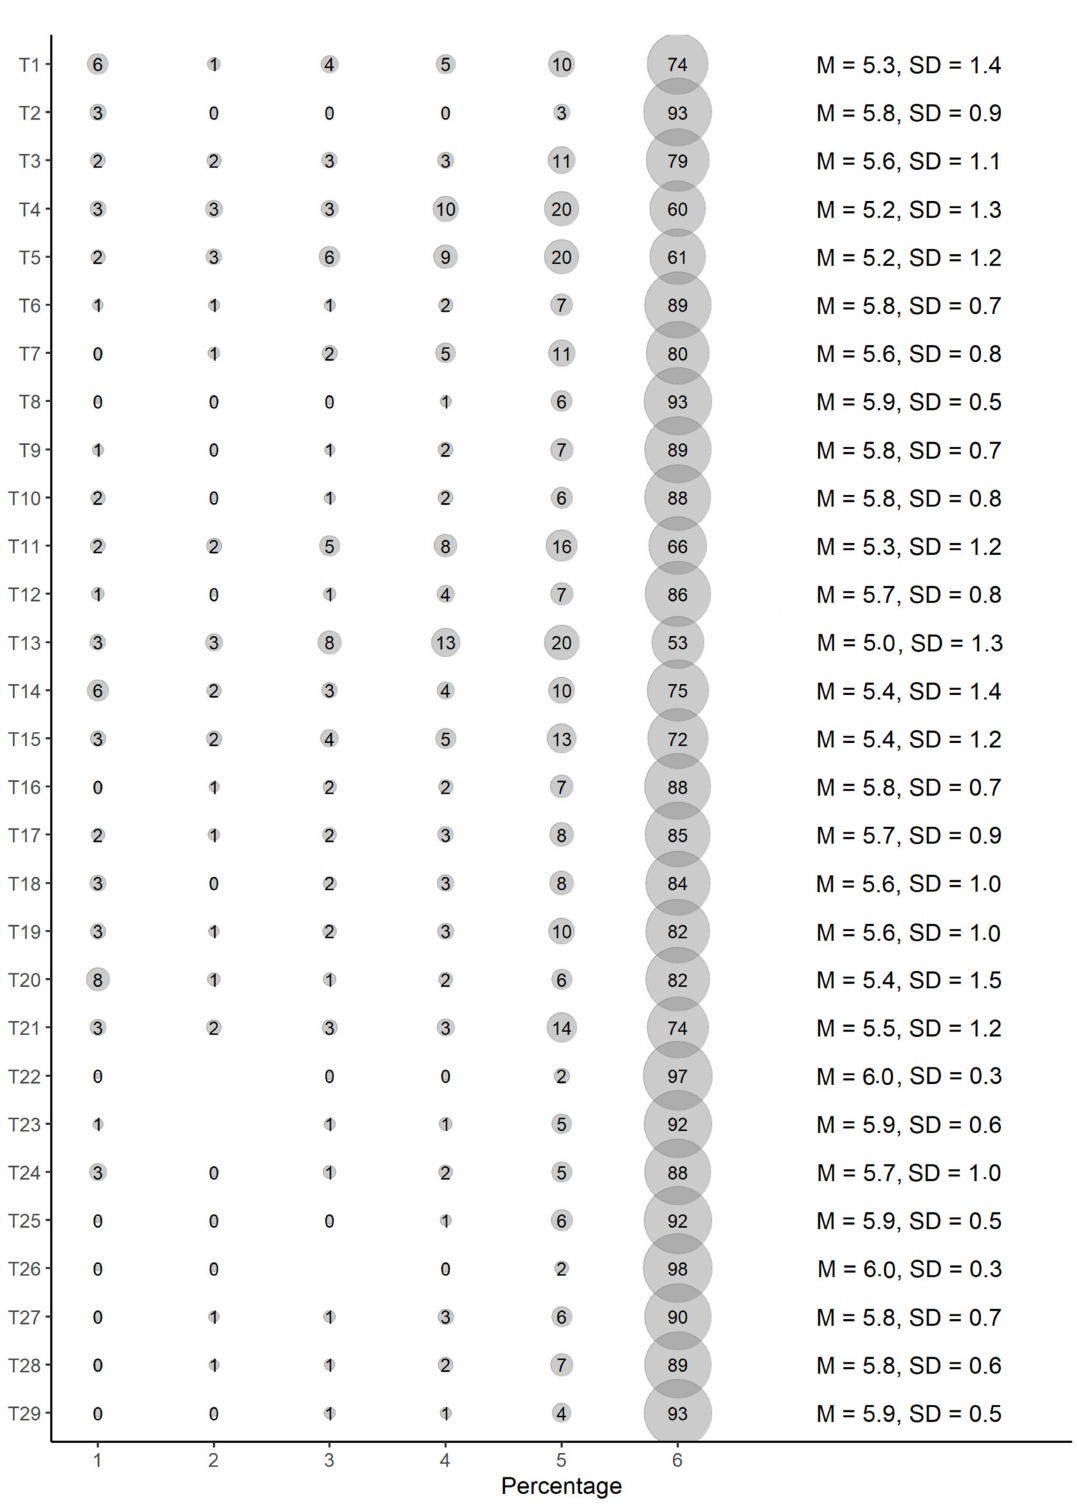
Figure 1. Frequencies and Mean and Standard Deviation for each